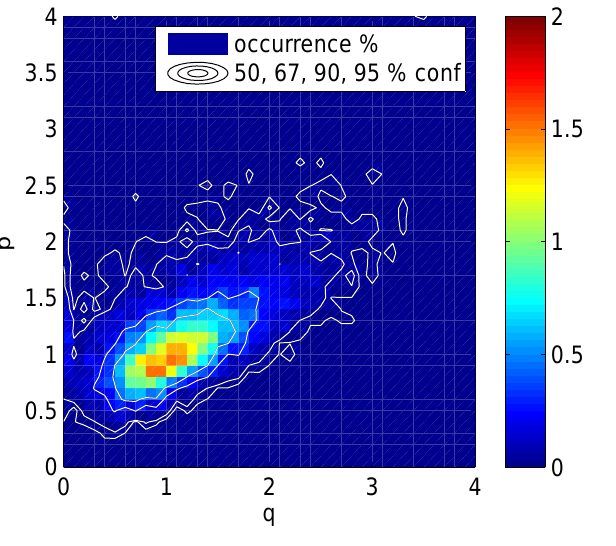
Fig. 3. Two-dimensional histogram of the occurrence rate of different values of p and q as best-fit values in η med = AM p (δN e0 /δz) q . Best-fits were obtained using 10000 random ice selections, each of 25 days, averaged to obtain η med and M ice . Con- fidence intervals are shown by the contours (50% confidence con- tour innermost). See text for further details.